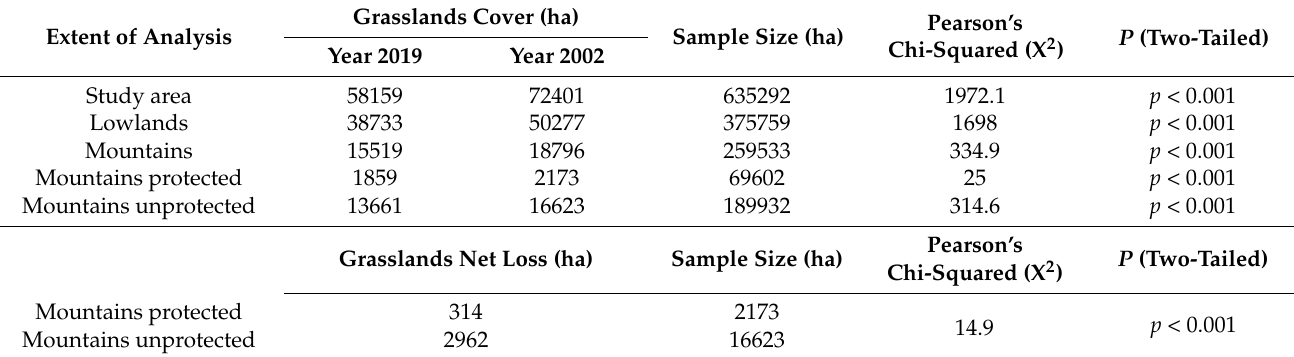
Table 3. Results of the two proportion Z-tests that compared: the proportions of grassland cover in 2019 and 2002 across the different extents of analysis to analyse the progress made in mountain grasslands conservation by 2020 (upper table); and the grasslands net loss between mountains protected and unprotected land governance regimes to understand to what extent does the protected governance regime affect grassland cover change and attenuate negative conservation tendencies (lower